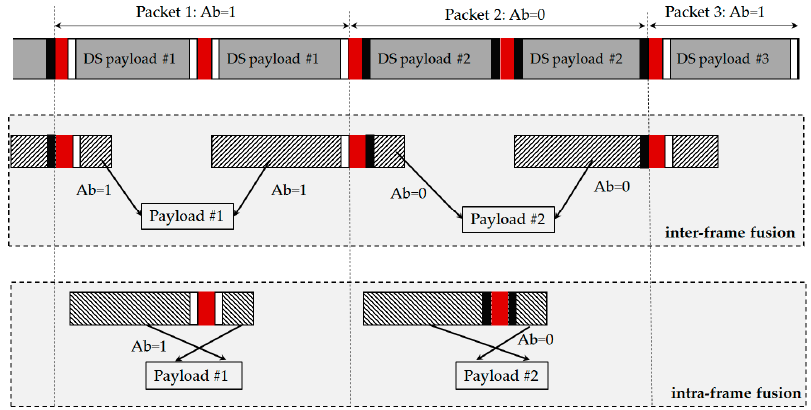
Figure 7. Data Fusion Algorithm. Inter-frame fusion : to group and fuse data parts from different images into a DS payload; Intra-frame fusion : to group and fuse data parts from an image into a DS payload.